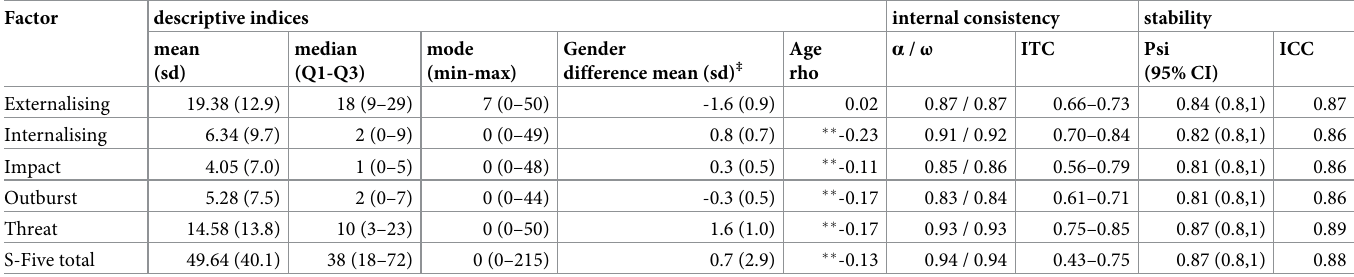
Table 2. Norms and reliability of the S-Five 5 factors and total scores (N =